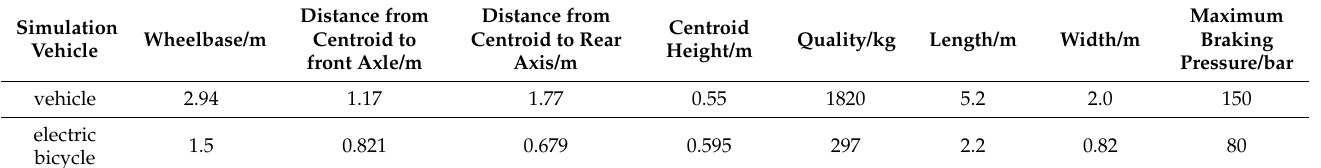
Table 2. Specific vehicle and electric bicycle